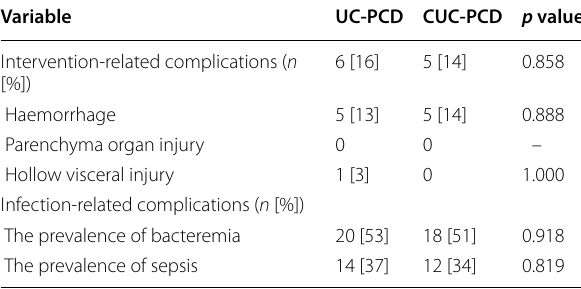
Table 4 Complications between the two groups Variable